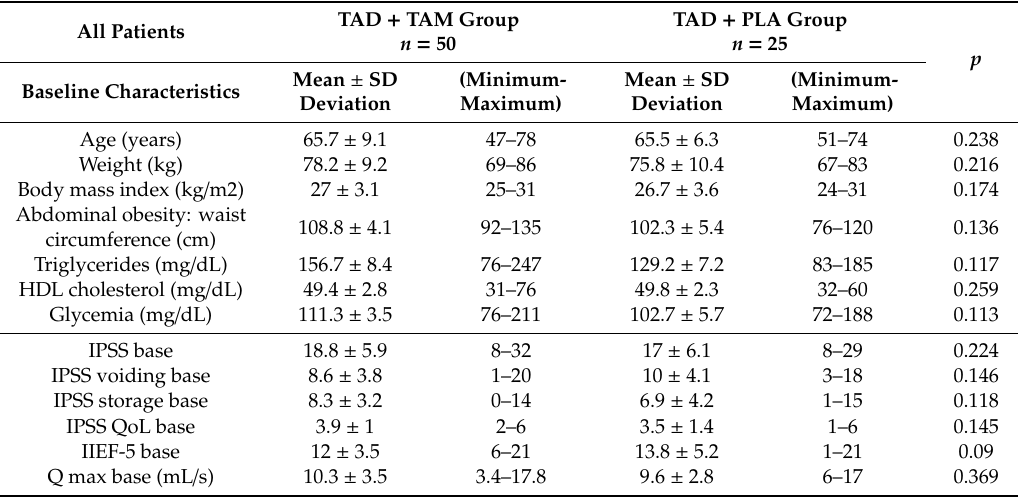
Table 1. Patients’ baseline characteristics.